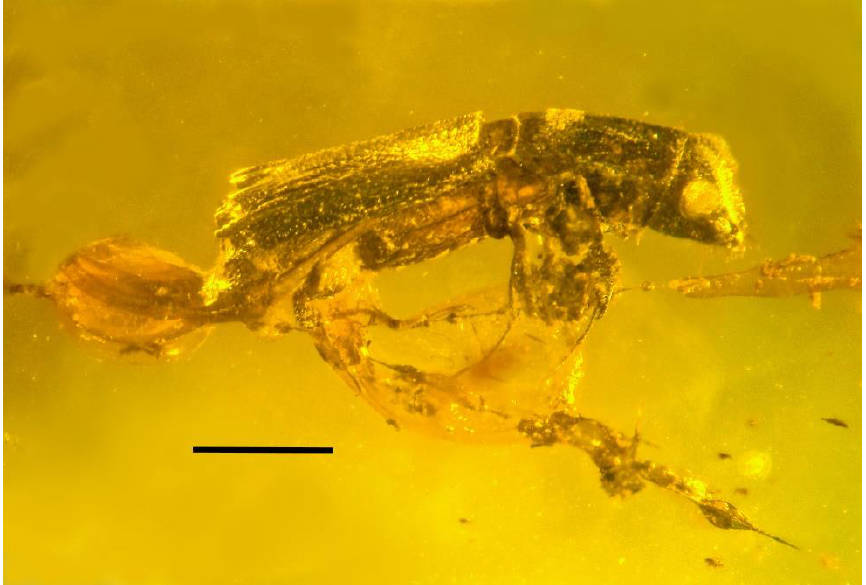
Figure 11. Platypodine beetle (Coleoptera: Curculionidae: Platypodinae) in spider web in Dominican amber. Scale bar = 950 µm.